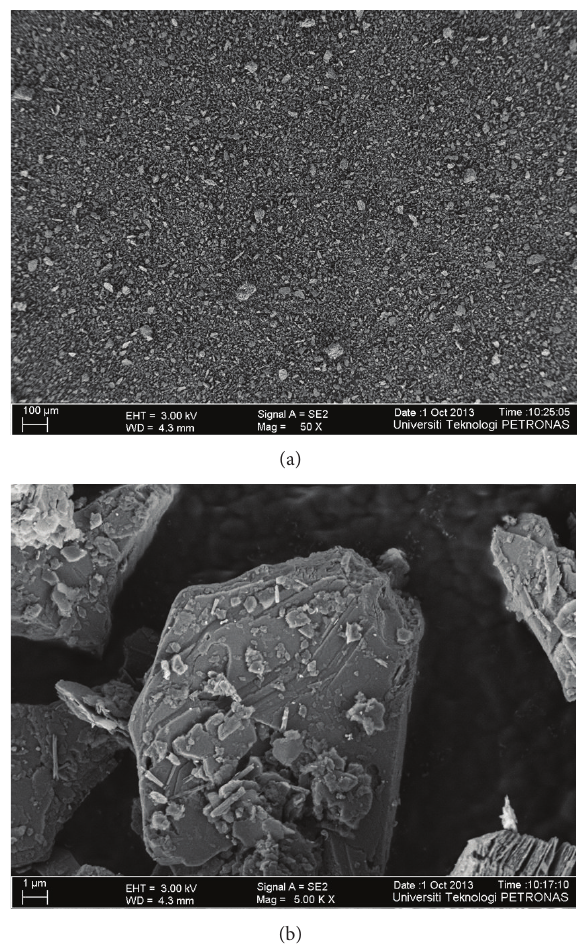
Figure 3: Microstructure of metakaolin through field emission scanning electron microscope (FESEM).